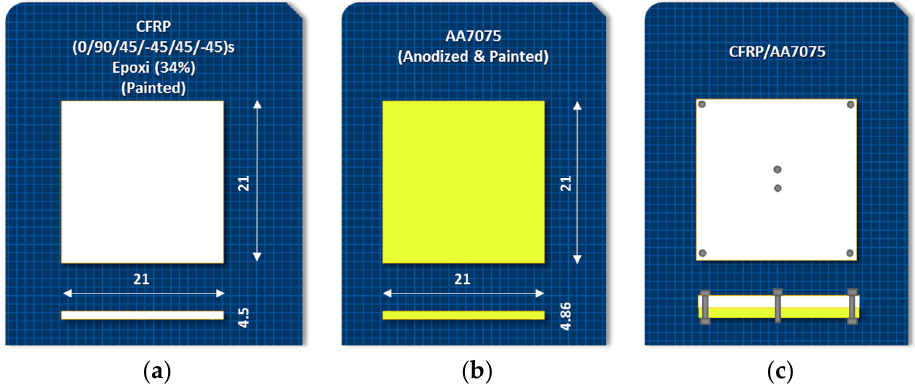
Figure 3. Characteristics and configuration of test materials: ( a ) CFRP; ( b ) UNS A97075 and ( c ) stacked CFRP/UNS A97075.